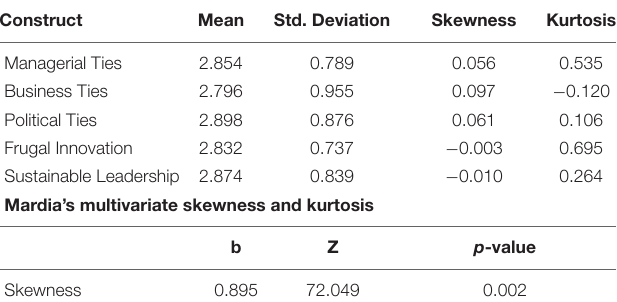
TABLE 1 | Mean, standard deviation, data normality.